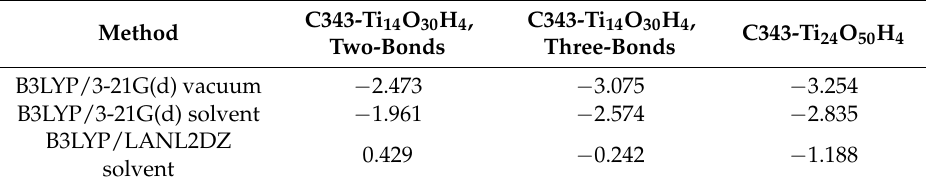
Table 5. The adsorption energy of the C343-Ti n O 2 n +2 H 4 systems ( n = 14, 24), defined as the difference between the calculated energy of the bound system and the sum of the energies for the separated constituents (isolated Ti 2 n O n +2 H 4 and C343), (in eV), calculated by the DFT/B3LYP method with 3-21G(d) or LANL2DZ basis sets, in vacuum or in water solvent.